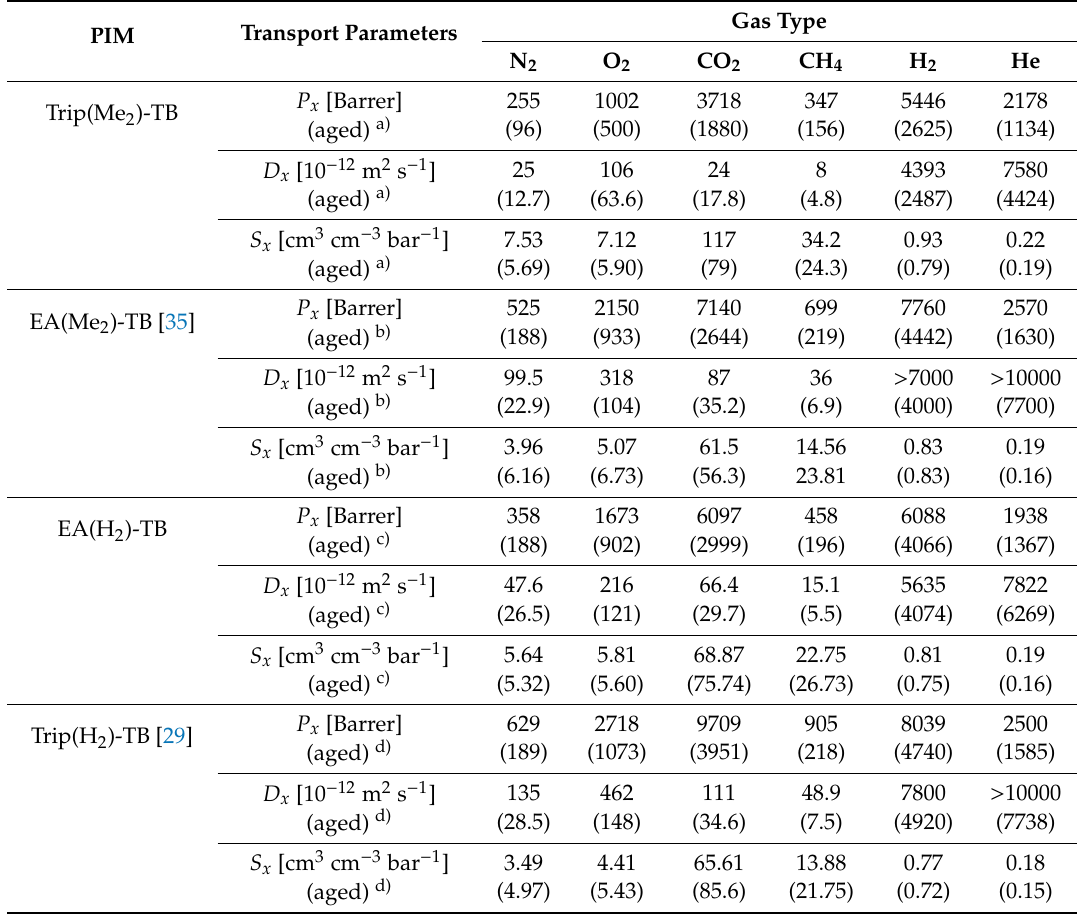
Table 2. Gas permeabilities P x , di ff usivity D x , solubility coe ffi cient S x for methanol treated films of TB-PIMs (data from aged films in parentheses and square brackets). Measurements at 25 ◦ C and 1 bar feed